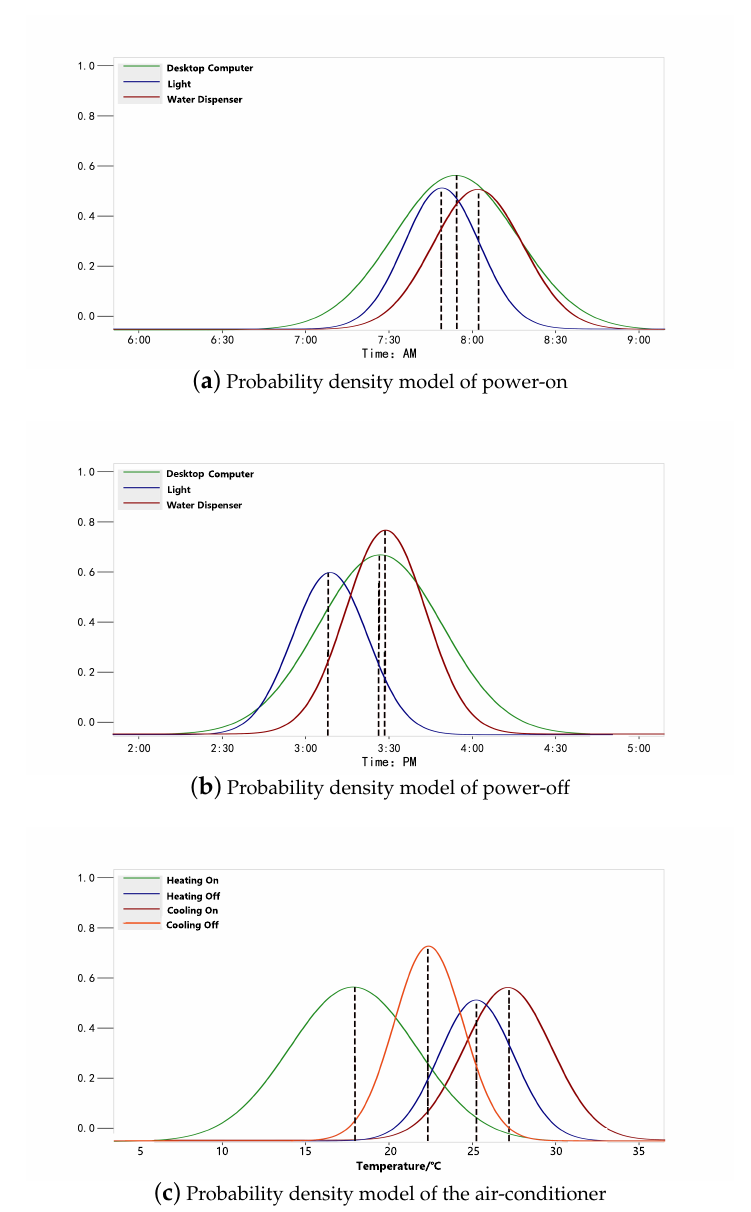
Figure 12. Action probability density model of the electrical